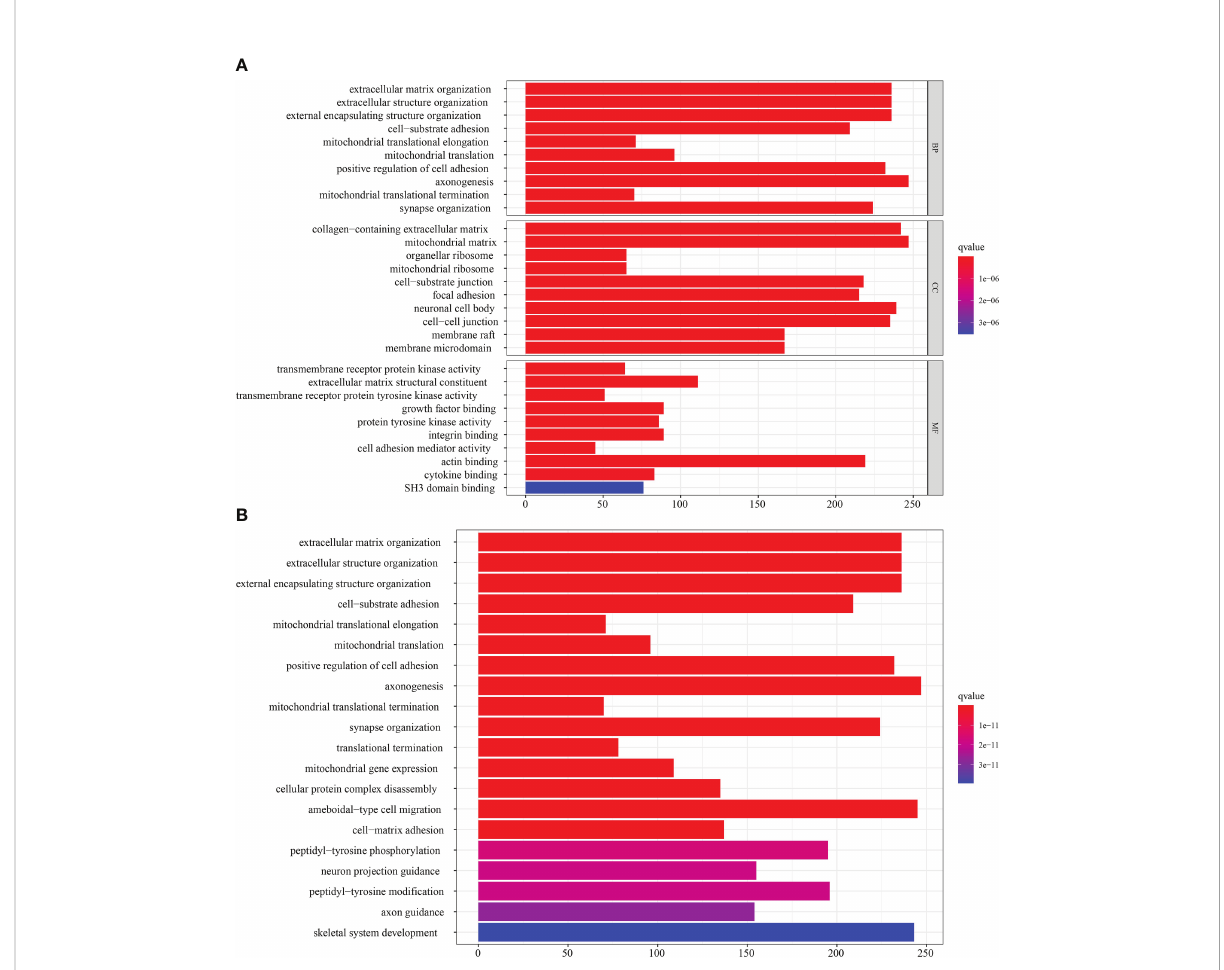
FIGURE 5 Transcriptome characteristics of NMNG modi fi cation patterns in STAD. (A) GO enrichment analysis of NMNG DEGs. (B) KEGG pathways of NMNG